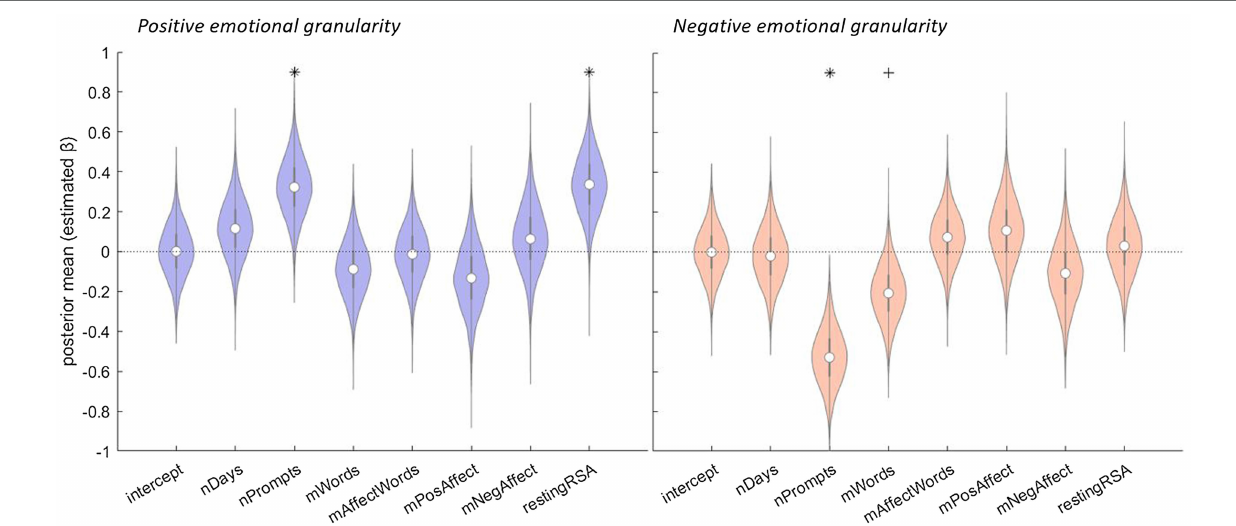
FIGURE 1 | The relationship between methodological and individual factors and change in emotional granularity over the course of ambulatory assessment. Left panel: positive granularity as the dependent variable. Right panel: negative granularity as the dependent variable. The results of Bayesian multiple regressions are shown. Violins represent the posterior distributions (i.e., estimated β s) for each factor based on 10,000 Monte Carlo samples. In the boxplots, the center dots represent medians, and the thick gray lines extend to the first and third quartiles. The whiskers extend from the quartile to 1.5 times the interquartile range. The likelihood of a factor’s relationship to change in emotional granularity (i.e., its posterior probability) is represented by the violins’ extents around zero, with zero indicated by the dotted horizontal black line. Factor names: nDays, number of days of ambulatory assessment included; nPrompts, mean number of experience sampling prompts responded to per day; mWords, mean length of event descriptions provided in end-of-day diaries; mAffectWords, mean percentage of affective language used in event descriptions; mPosAffect, mean self-reported positive affect; mNegAffect, mean self-reported negative affect; and restingRSA, mean respiratory sinus arrhythmia value across all periods of ambulatory seated rest. * probability ≥ 95%; + probability ≥